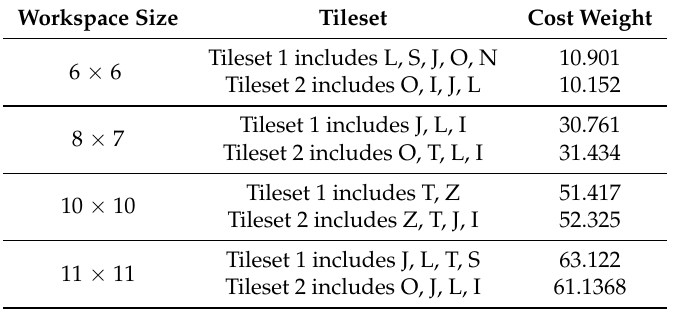
Table 3. Cost weight comparison between different tilesets for the same workspace.